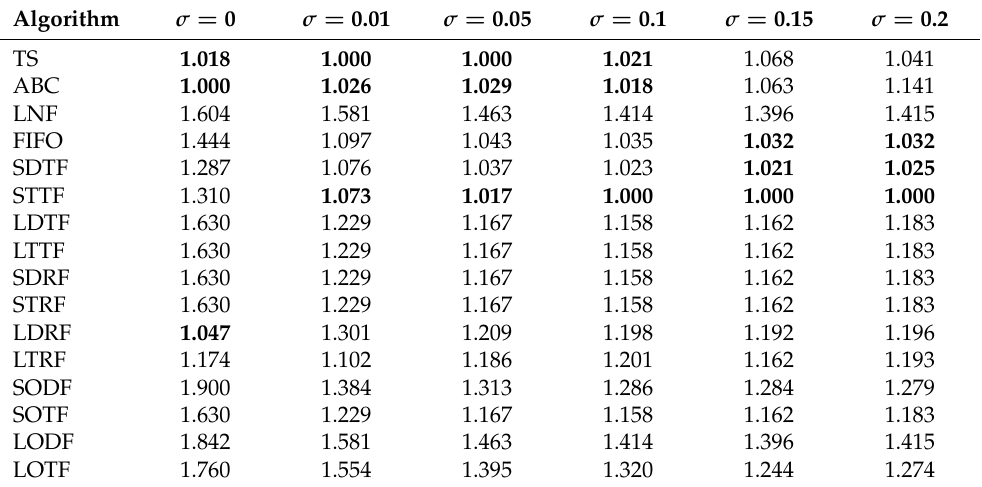
Table 2. PRD results for instance no. 13 ( n = 3) with 121 sectors and 132 resources (best three results for each scenario type in bold).